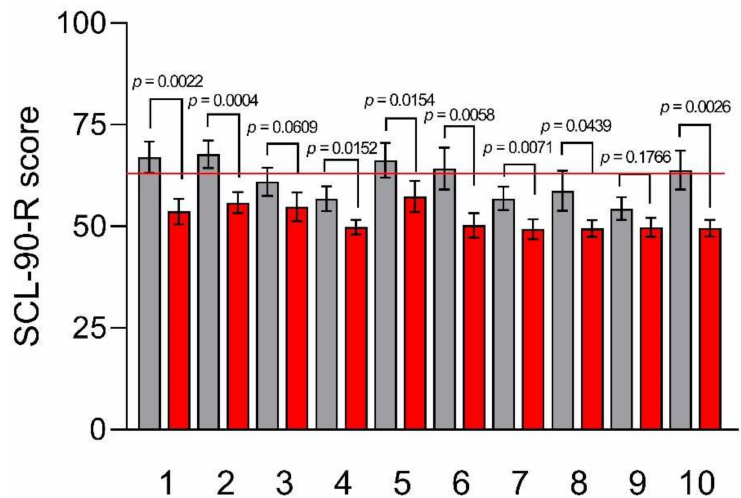
Figure 4. SCL-90-R subscale scores before and after the Tritordeum-based diet. Data are expressed as means ± SEM and analyzed by the Wilcoxon matched-pairs signed rank test. All differences were considered significant at p < 0.05. Subscales: ( 1 ) GSI; ( 2 ) somatization; ( 3 ) obsessive-compulsive; ( 4 ) interpersonal sensitivity; ( 5 ) depression; ( 6 ) anxiety; ( 7 ) hostility; ( 8 ) phobic anxiety; ( 9 ) paranoid ideation; and ( 10 ) psychoticism. The red line indicates the cut-off value (63). Grey columns (Pre-diet), red columns